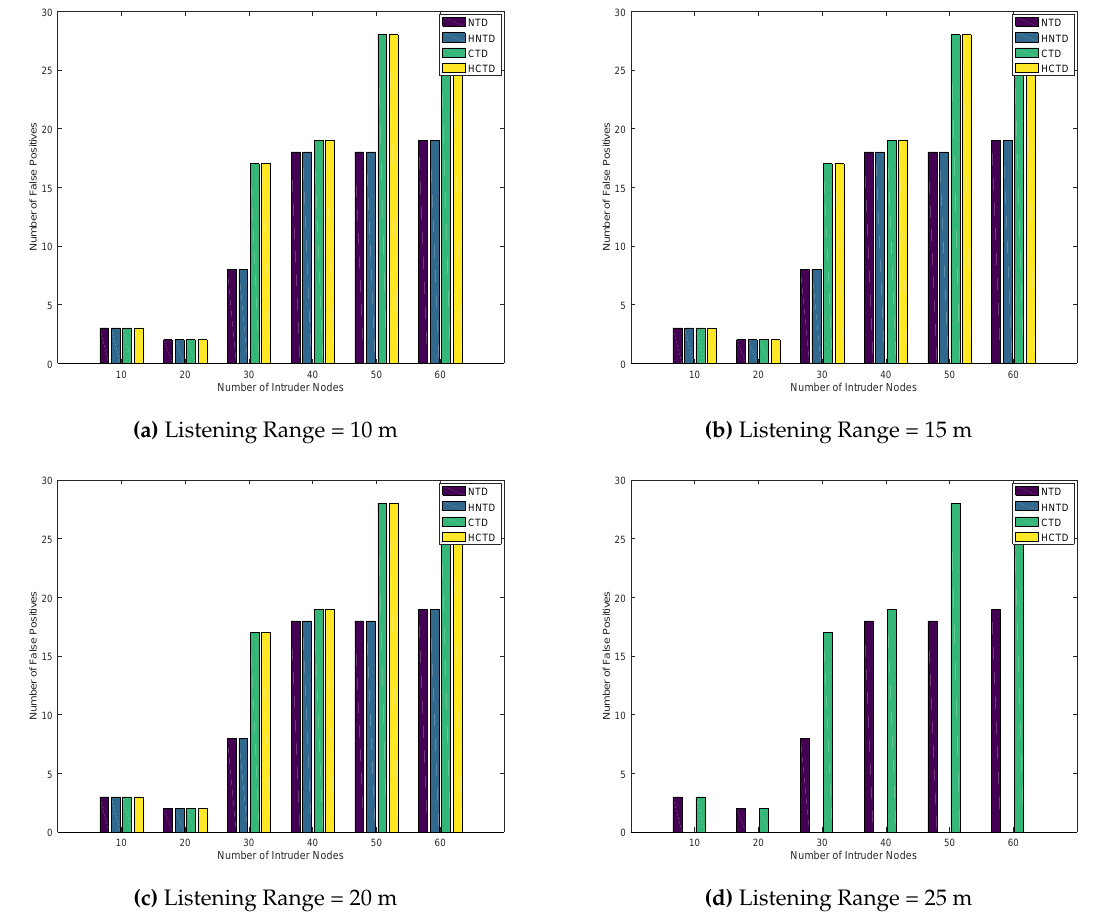
Figure 5. Number of False Positives for Homogeneously placed